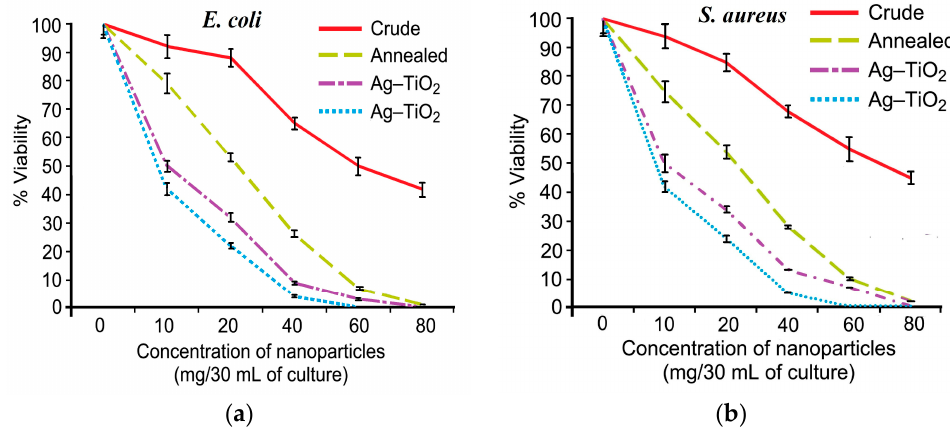
Figure 19. Viability of ( a ) E. coli and ( b ) S. aureus against the concentration of as-synthesized TiO 2 NPs, annealed TiO 2 NPs, and Ag-doped TiO 2 NPs with 3% AgNPs (dash–dot curve) and 7% AgNPs (dot curve; blue). Reproduced with permission from [256]. Copyright Beilstein-Institut, 2013.